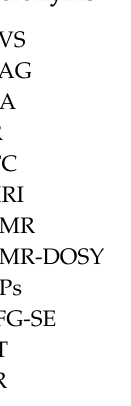
Figure S1: Fitting of ITC data for Gd-DTPA titrated into 0.1% w / v HA, Table S1: Values of water self-di ff usion coe ffi cient at di ff erent DVS concentrations measured at 20 MHz after 8 h and 24 h from DVS addition, Table S2: Longitudinal relaxation times of the crosslinked and non-crosslinked samples without Gd-DTPA measured with Saturation and Inversion Recovery sequences, Table S3: Relaxivity of the crosslinked and non-crosslinked samples without Gd-DTPA measured with Saturation and Inversion Recovery